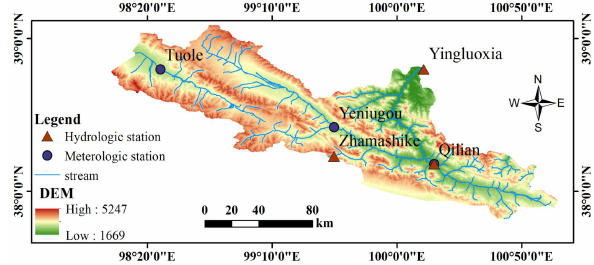
Figure 1 . Upper reaches of the Heihe River